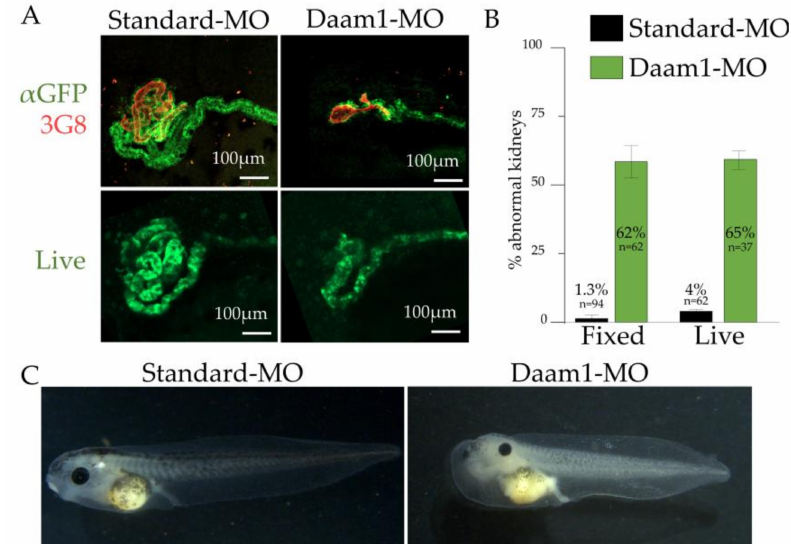
Figure 9. Disruption of kidney development using Daam1 morpholino (MO) can be tracked by cdh17 :eGFP. cdh17 :eGFP transgenic embryos were injected with Standard or Daam1 morpholino, then stage 42 embryos were assayed for kidney abnormalities. ( A ) Representative images of kidneys under indicated conditions. ( B ) Percentage of abnormal kidneys under indicated conditions. ( C ) Daam1 morpholino was injected into both V2 blastomeres, resulting in the development of edema, which indicates kidney functional defects. Arrow indicates site of